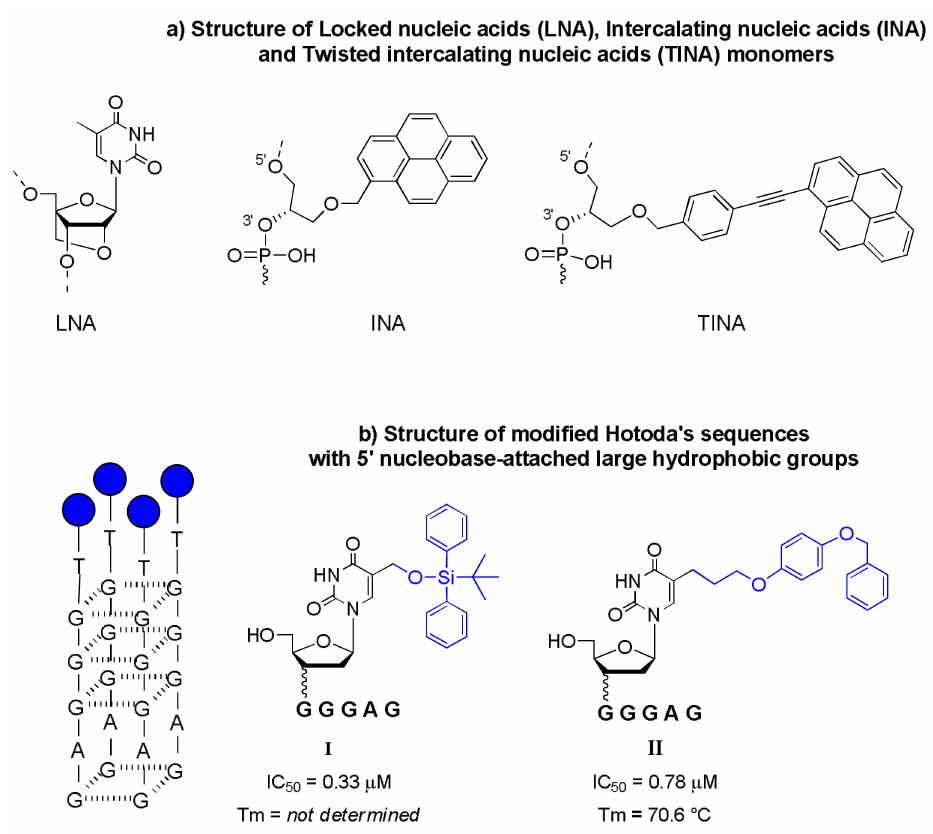
Figure 3. Schematic representation of the modified Hotoda’s sequences at nucleobases: ( a ) insertion of LNA, INA and TINA monomers in different position of d(TGGGAG) sequence [38]; ( b ) the most active modified d(TGGGAG) sequences with the insertion of aromatic groups at 5 (cid:48) -end thymidine nucleobase